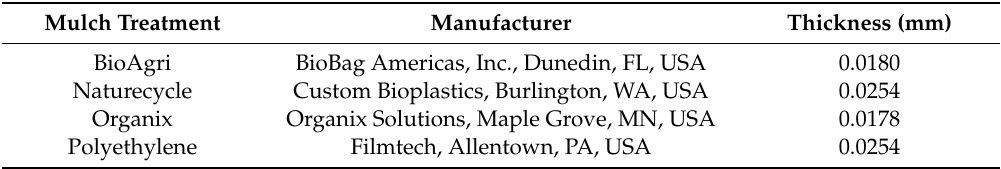
Table 2. Plastic mulch treatments evaluated for pumpkin production in Knoxville, TN, USA, in 2015 and